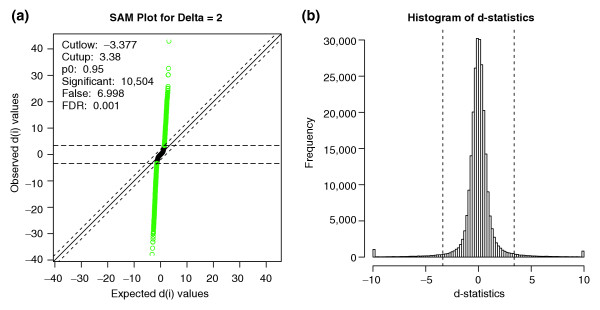
Distribution of single-feature polymorphisms. (a) The observed d-statistics (y-axis) is plotted against the expected d-statistics (x-axis) as determined by permutations. 10,504 significant SFPs exceeding the threshold of 0.1% FDR are shown in green. (b) Histogram of d-statistics truncated at ± 10. Positive scores above the threshold 3.38 are Golden Promise SFPs, and negative scores below -3.37 are Morex SFPs.